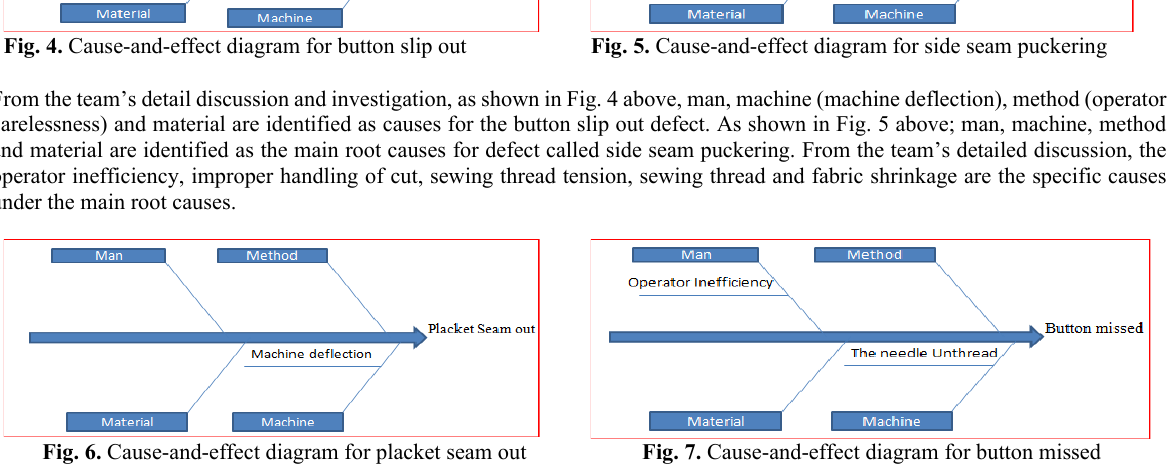
Fig. 4. Cause-and-effect diagram for button slip out Fig. 5. Cause-and-effect diagram for side seam puckering